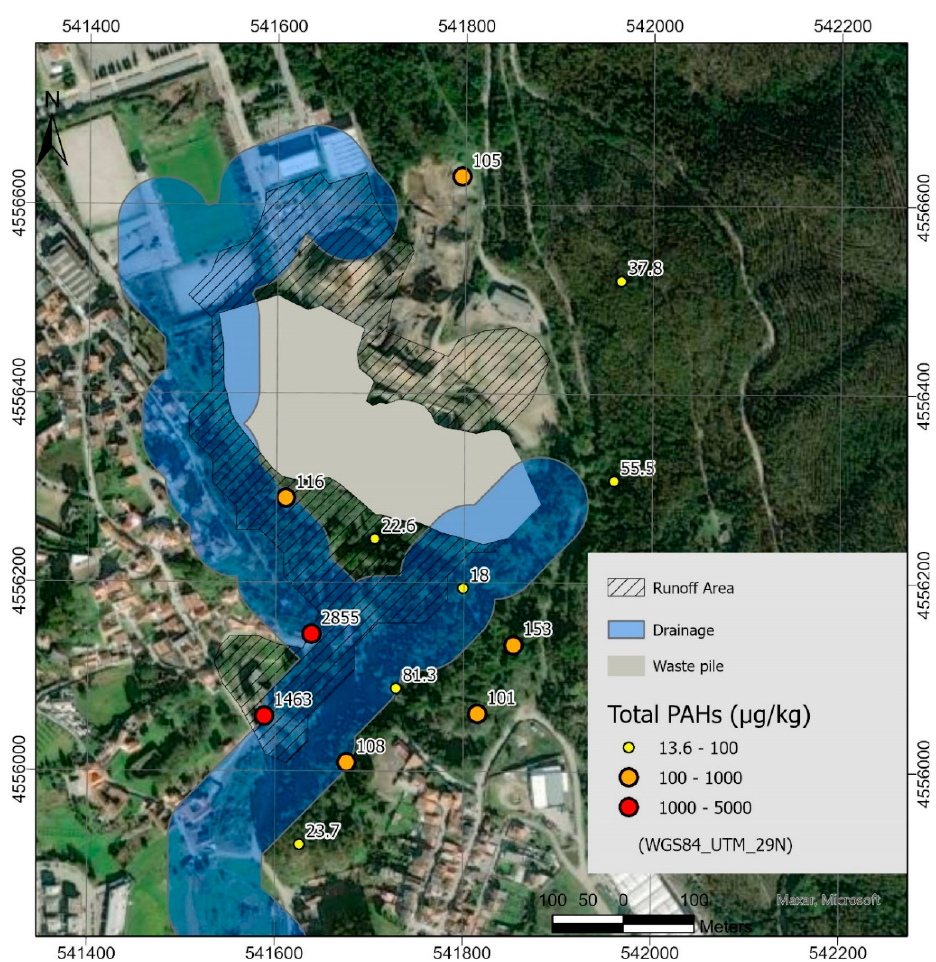
Figure 10. Spatial distribution of the sum of the 16 priority PAHs analysed in soil samples. Table 8 compiles the LMW and HMW PAHs percentages distributed in the soils upstream of the waste pile, along the runoff areas and influenced by small piles of waste.